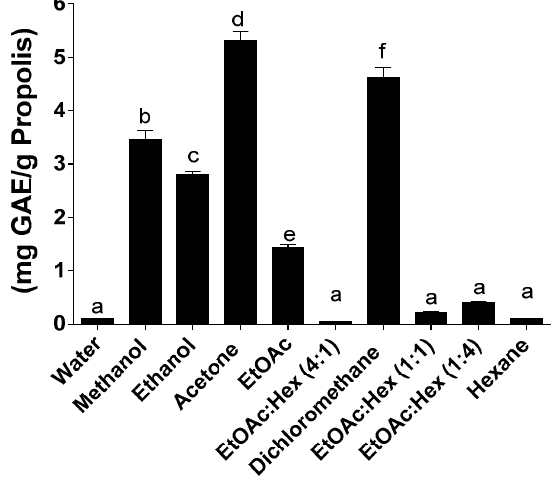
Figure3. TotalphenoliccontentfollowingUAE.Valuesarethemeans ± SEMofatleastthreeindependent Figure 3. Total phenolic content following UAE. Values are the means ± SEM of at least three experiments, each performed in duplicate; values with di ff erent superscripts are significantly di ff erent independent experiments, each performed in duplicate; values with different superscripts are ( p < 0.05) as determined by one-way ANOVA test with subsequent Tukey’s adjustment; GAE: gallic significantly different ( p < 0.05) as determined by one-way ANOVA test with subsequent Tukey’s acid adjustment; GAE: gallic acid equivalent.